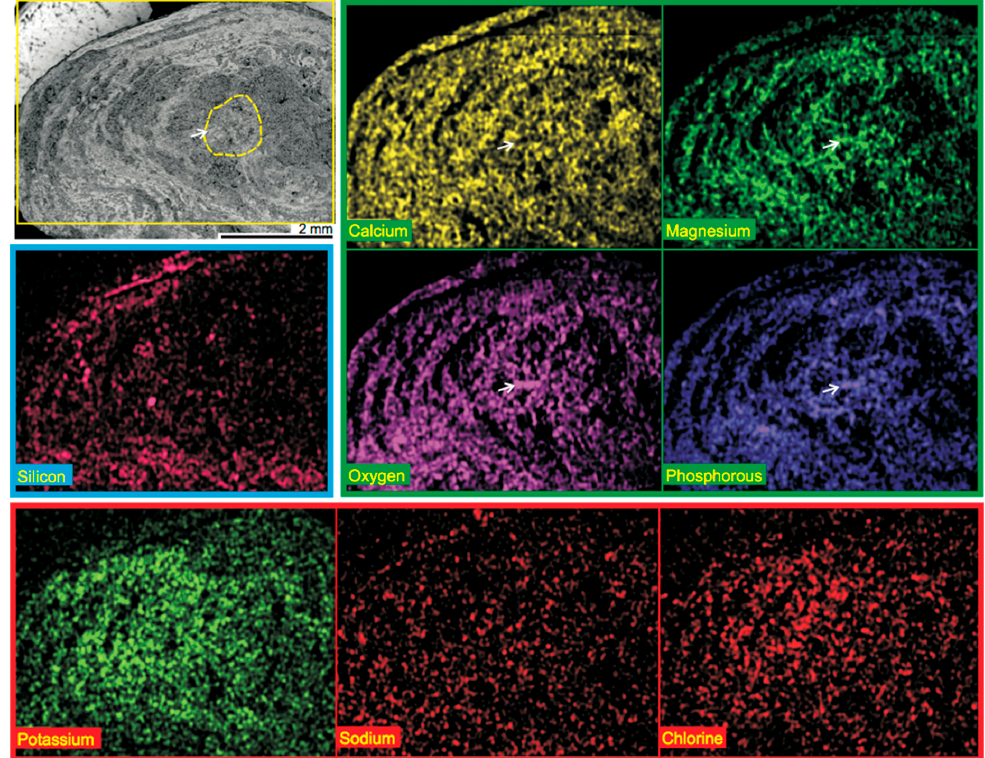
Figure 5. Energy-dispersive X-ray spectroscopy (EDS) maps of a cross-polished urinary stone from a guinea pig (overview, see Figure 6 for a magnified view). The top left image is the corresponding scanning electron micrograph, and the yellow frame indicates the area selected for EDS mapping. White arrows highlight an exemplified feature, where magnesium, oxygen, and phosphorous are abundant, but not calcium. This feature shows that although the contents of struvite and calcium carbonate are similarly distributed, larger individual grains can be identified. It may be speculated that struvite served as an initial seed within the yellow dashed area highlighted in the top left image. The EDS maps are grouped according to similar distributions within the urinary stone; calcium, magnesium, oxygen, and phosphorous ( green frame ); potassium, sodium, and chlorine ( red frame ); and silicon ( blue frame